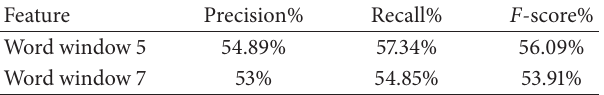
Figure 3: SL constituent trees to word’s sliding window. Table 1: Performance of overall NER system on linear SVM using word features.